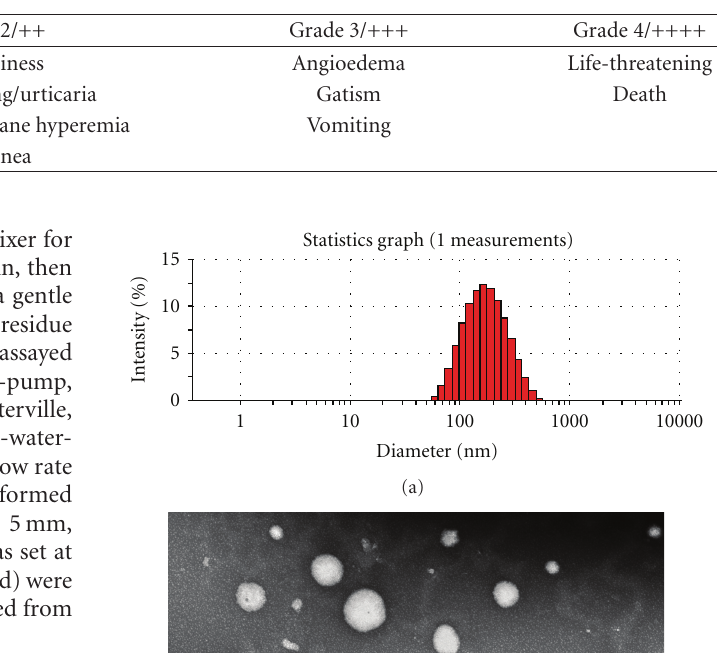
Table 1: The severity of allergic reactions.